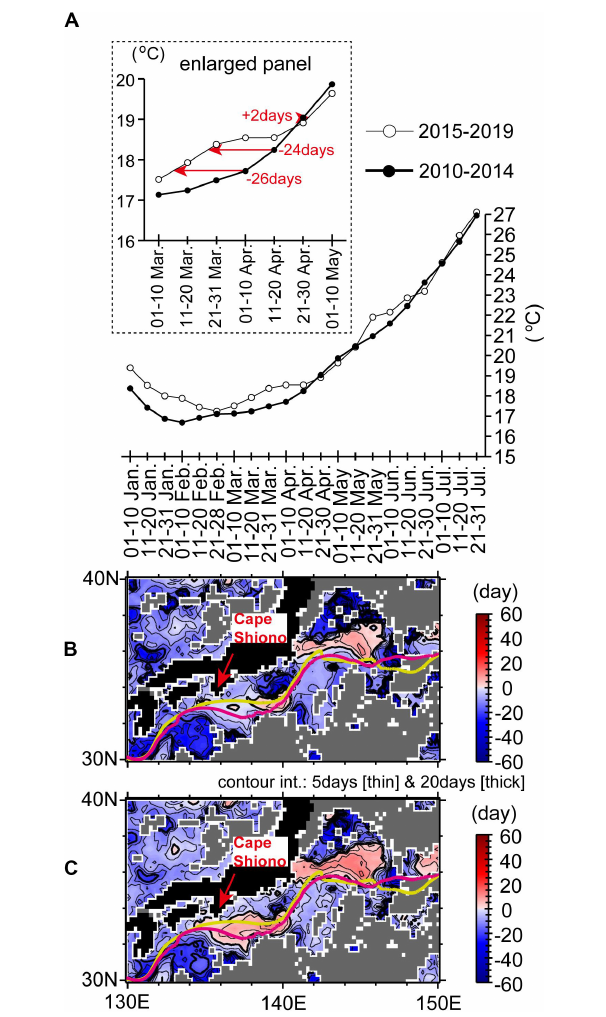
FIGURE 12 | (A) SSTs at 139.875 ◦ E, 34.375 ◦ N averaged for 2010–2014 (closed circles) and 2015–2019 (open circles) over intervals of about 10 days. Red arrows with numerals in the upper-left enlarged panel indicate time deviations of 10-day SSTs in April for 2010–2014 from the seasonal cycle of SSTs for 2015–2019. The deviations are illustrated as a map of the monthly (B) maximum and (C) mean. Yellow-green (pink) lines in (B,C) indicate the Kuroshio axis position averaged for April in 2010–2014 (2015–2019). Gray shading means that the minimum of 10-day SSTs in April for 2010–2014 was lower than the minimum of 10-day SSTs throughout the year for 2015–2019.